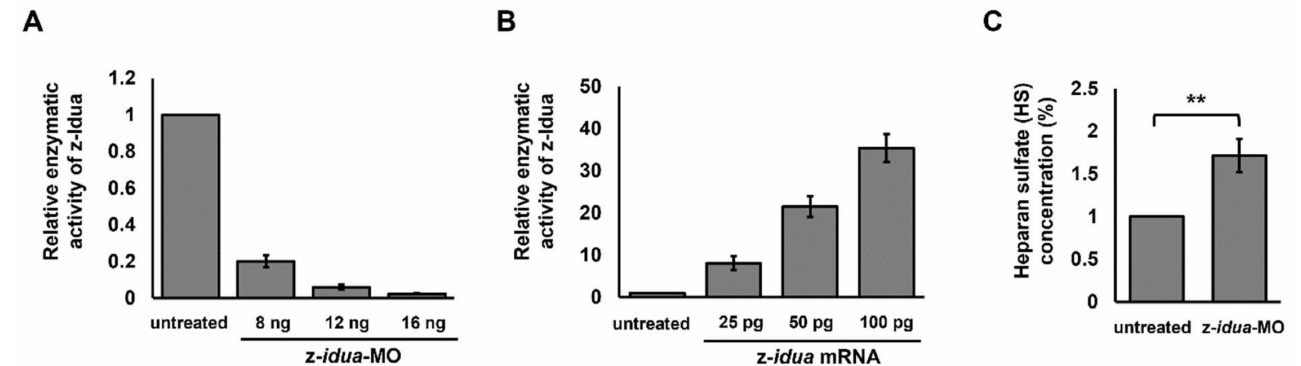
Figure 1. Both z-Idua enzymatic activity and the accumulation of heparan sulfate (HS) in zebrafish embryos were closely correlated with knockdown or overexpression of z- idua mRNA injected into zebrafish embryos. ( A ) Zebrafish embryos at one-cell stage were injected with different doses of z- idua -MO, as indicated, followed by detection of z-Idua enzymatic activity at 24 hpf. The z-Idua enzymatic activity of the untreated control group was normalized as 1 for comparison with embryos injected with different doses of z- idua -MO. ( B ) The z-Idua enzymatic activity of zebrafish embryos injected with different doses of z- idua mRNA, as indicated. The z-Idua enzymatic activity of the untreated control group was normalized as 1 for comparison with the embryos injected with different doses of z- idua mRNA. ( C ) HS concentration was detected at 120 hpf of zebrafish embryos injected with 12 ng of z- idua -MO. The HS concentration of the untreated control group was normalized as 1 for comparison with the z- idua -MO-injected embryos. One trial experiment was carried out for 40 larvae. Data of each group were averaged from three independent experiments. Student’s t -test was used to determine significant differences between the two groups (**, p <